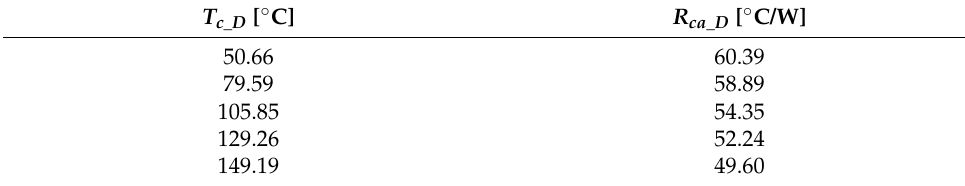
Table 3. R ca for the